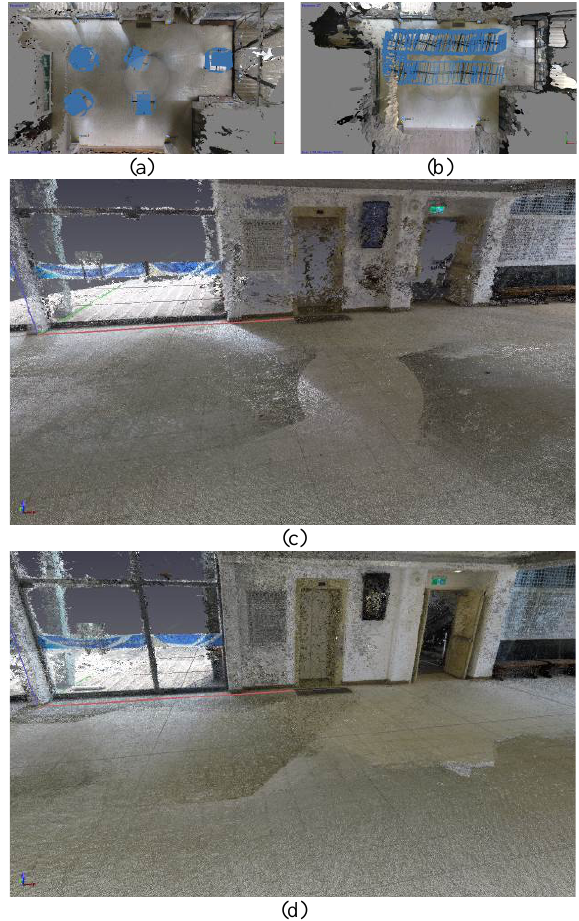
Figure 8. Results of a lobby: (a) perspective centres of 12MP images; (b) perspective centres of 4K video frames; (c) points from 12MP image; (d) points from 4K Table 5. Comparison of images and videos for a lobby 12MP 4K video